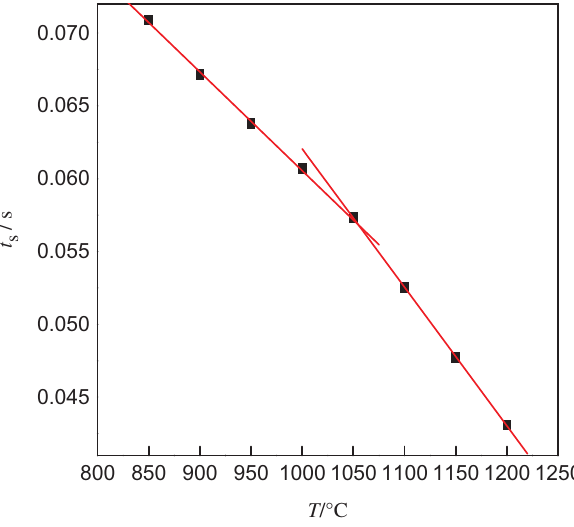
Figure 11: Relationship between recrystallization starting time t s and deformation temperature